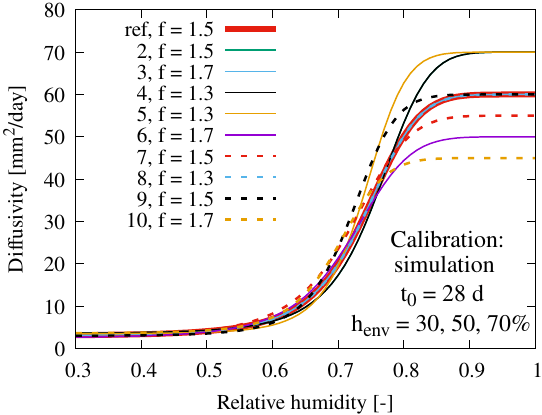
Figure 4. Di ff usivity functions giving the best agree- ment with the axial shrinkage from the simulation of symmetrically drying concrete slab ( D = 150 mm, h env = 50%, t 0 = 28 days) computed with the refer- ence set of material parameters.